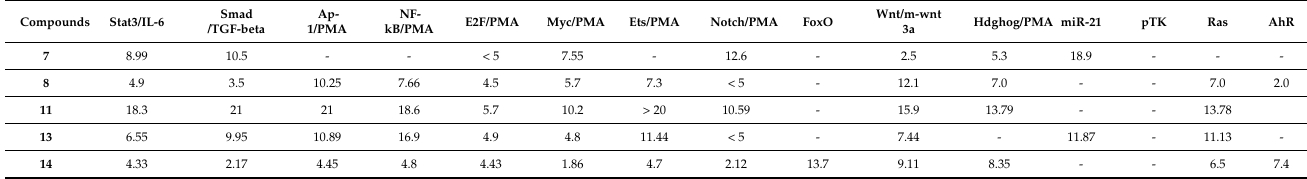
Scheme 5. Schematic assay protocol of cancer-related signaling transduction pathways using T98G glioblastoma multiforme cells. Table 4. Activity* of compound 7 , 8 , 11 , 13 , and 14 against cancer-related signaling pathways in T98G glioblastoma multiforme cells. #